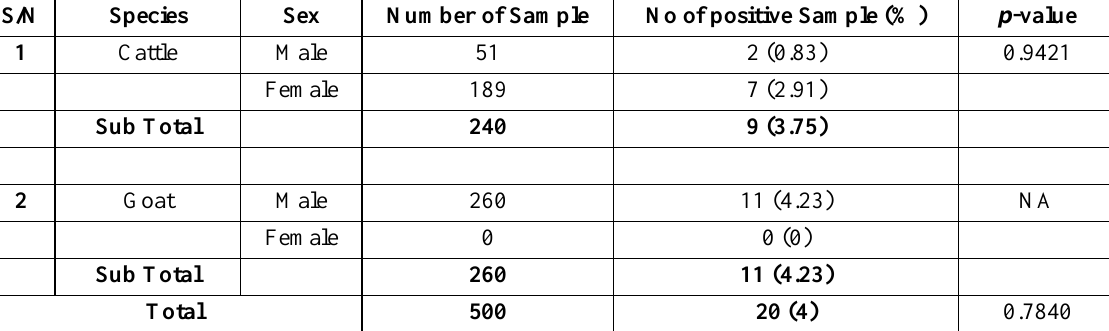
Table 1. Isolation rate of Salmonella species from ruminants slaughtered at the two major abattoirs in Ilorin, Kwara